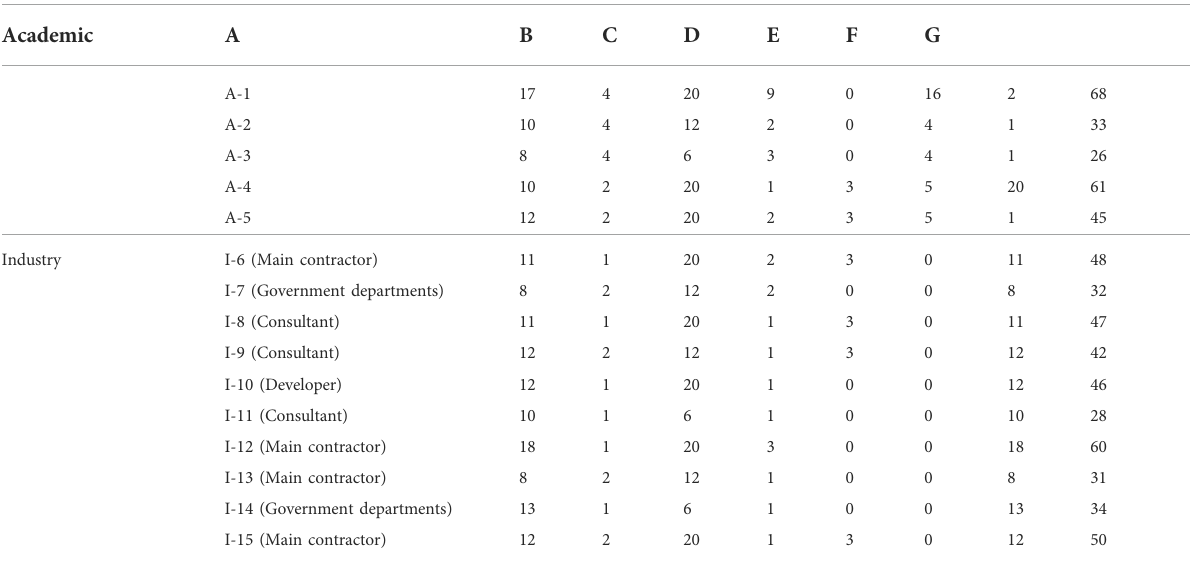
TABLE 3 Pro fi les and quali fi cations of the experts (N = 15). Expert panellists Quali fi cations